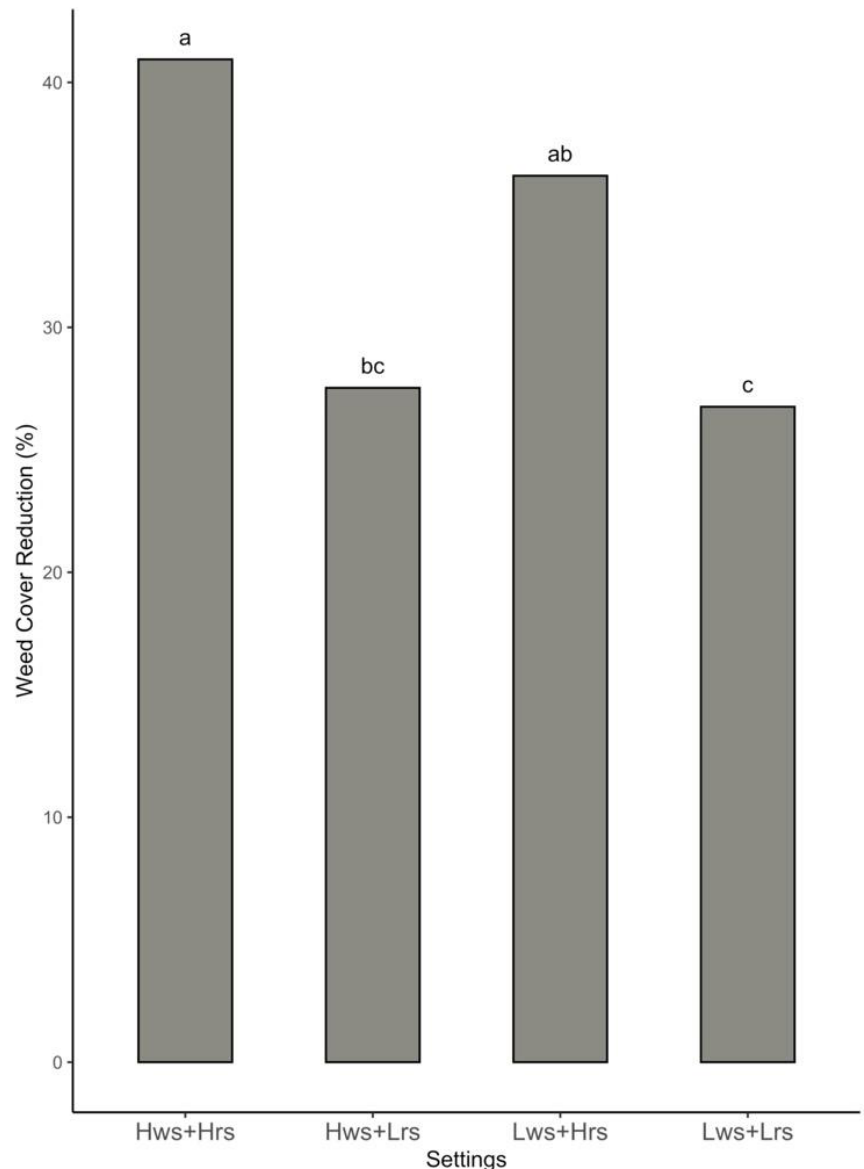
Figure 11. Effect of setting configuration on weed cover reduction. Means denoted by different letters are significantly different at p < 0.05 (LSD test). Hws—High working speed; Lws—low working speed; Hrs—high rotation speed; Lrs—low rotation speed.